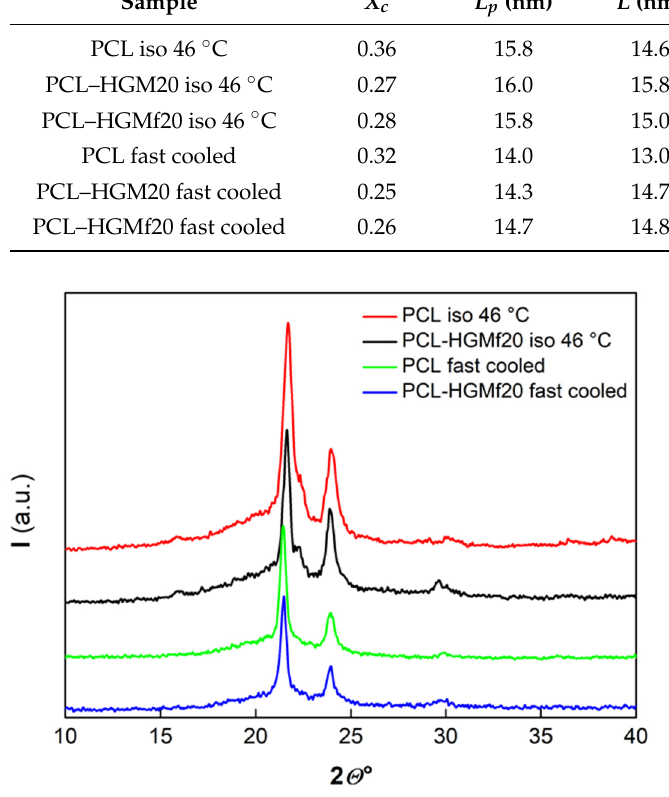
Figure 9. WAXD patterns for pure PCL and PCL–HGMf20 composite.